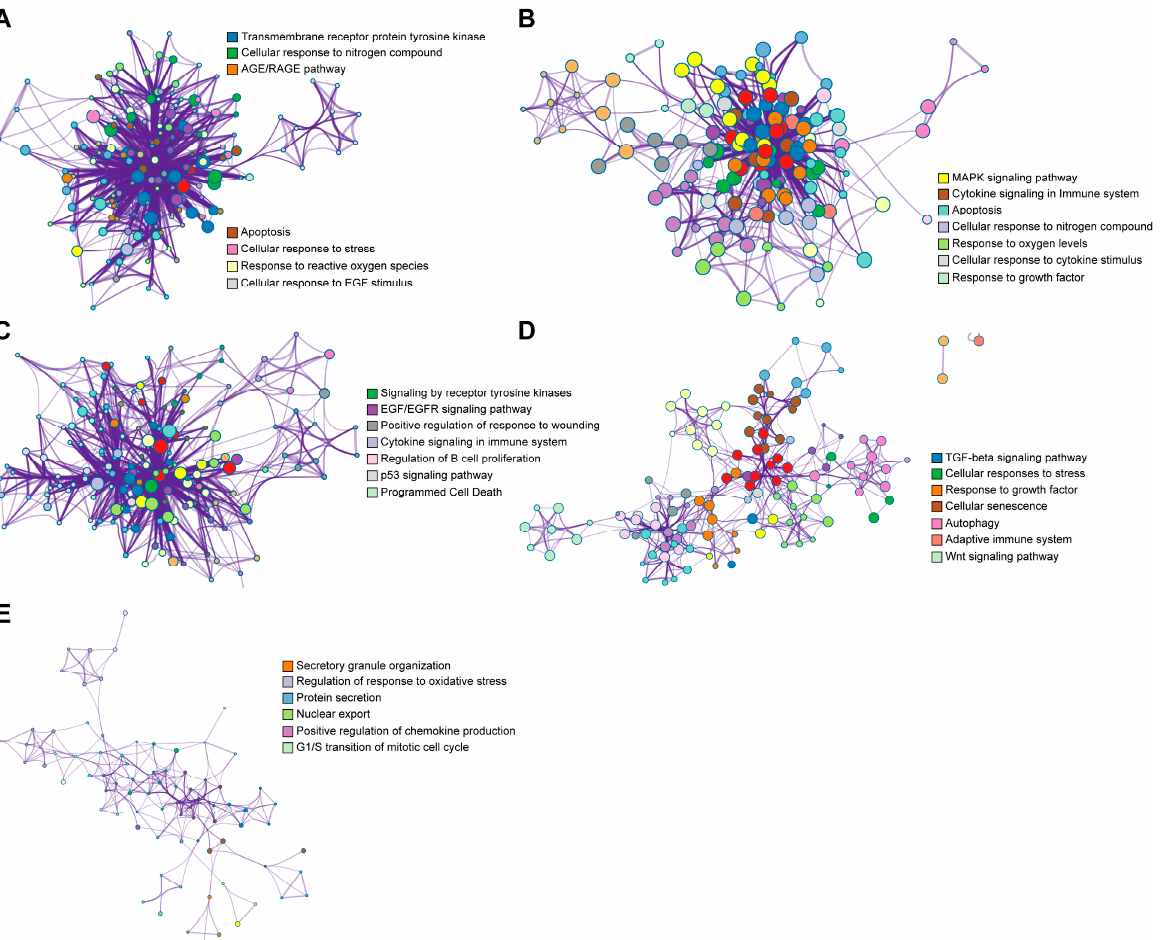
Figure 6. Functional annotations of the five miRNA pairs in the model. ( A – E ) Network of signaling pathways and biological processes enriched in the target genes of miRNA pair 1–5. Similar enriched terms are close to each other and connected by edges.